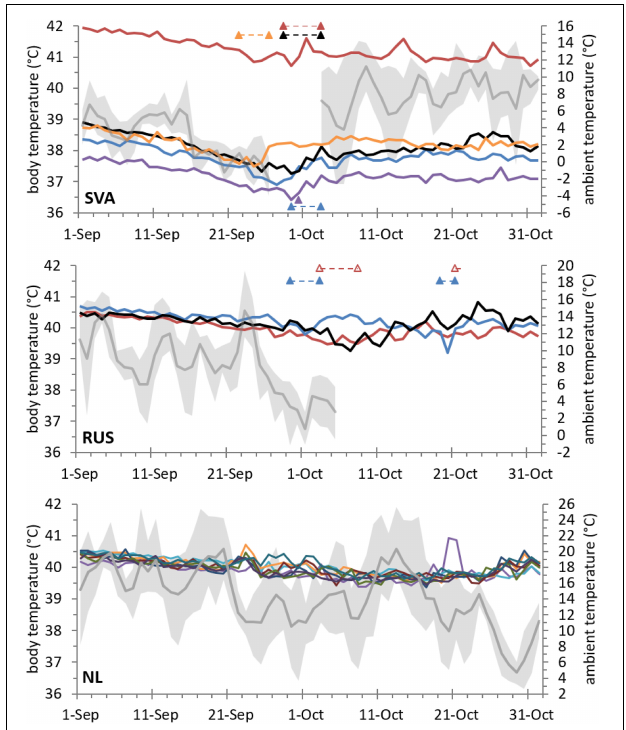
FIGURE 5 | Daily Tb (left axis) of barnacle geese before, during, and after their autumn migration from Svalbard (SVA) to the United Kingdom, from Russia (RUS) to (pre-) wintering grounds in the SW Baltic and Wadden Sea, and of non-migratory individuals in the Netherlands (NL). Shown is the MESOR Tb as modelled from a multi-component cosinor analysis, which equated to daily mean Tb in these data. Migratory movements are indicated by triangles matching in colour with the individual Tb series; if the triangles are connected by dashed lines, then migratory activity was recorded throughout this period. The timing of movements was derived from individual heart rate (SVA) or GPS tracking (RUS); in one case (open triangles) it was estimated from obvious phase shifts observed in Tb data ( Figure 1 ). The grey line and the borders of the grey shaded area surrounding it refer to daily mean, maximum, and minimum ambient temperature (right axis) as measured in the breeding area before most individuals departed; for Svalbard geese (with a condensed migratory period) ambient temperature is also shown in their Scottish wintering